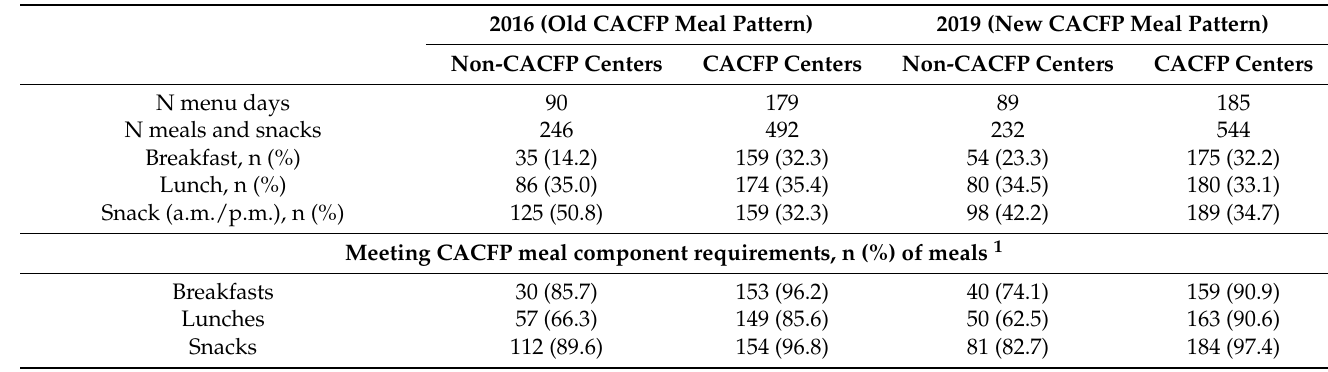
Table 2. Frequencies of menus meeting CACFP minimum standards and voluntary best